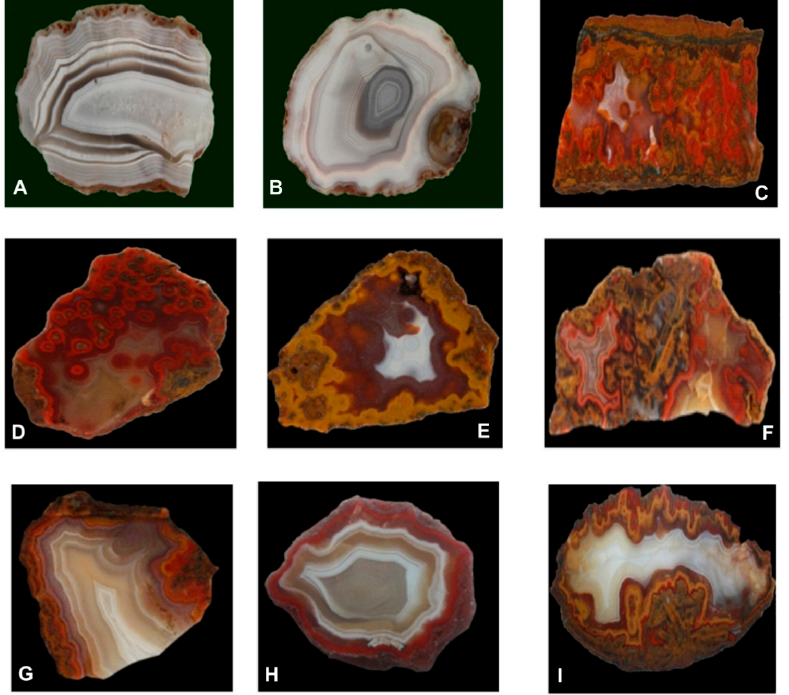
Figure 2. Kerrouchen agates: ( A ) monocentric agate with osculum, 3.5 × 5.5 × 2.9 cm, greyish white internal and reddish to dark-brown external zone; ( B ) monocentric agate, 3.2 × 4.1 × 2.1 cm, greyish white to pinkish internal and reddish to dark-brown external zone; ( C ) pseudostalactie agate, 3.2 × 5.8 × 1.1 cm, light-brown, reddish, orange to greyish-white interior and light-brown external zone; ( D ) polycentric agate, 6.1 × 4.5 × 1.5 cm, pink, red to orange interior and light-brown external zone; ( E ) pseudostalactite agate, 3.4 × 4.4 × 0.9 cm, orange, red, brown to greyish-white interior and light-brown external zone; ( F ) pseudostalactite agate, 2.9 × 6.6 × 1.3 cm, orange, red, brown to greyish-white interior and light-brown external zone; ( G ) monocentric agate, 3.5 × 6.0 × 1.3 cm, light-brown, orange to greyish-white interior and dark-brown external zone; ( H ) monocentric agate, 4.0 × 4.3 × 1.1 cm, light-brown to greyish-white interior and dark-brown to red external zone; ( I ) pseudostalactite agate, 6.2 × 11.5 × 0.5 cm, light-brown, orange to greyish-white interior and light-brown external zone.